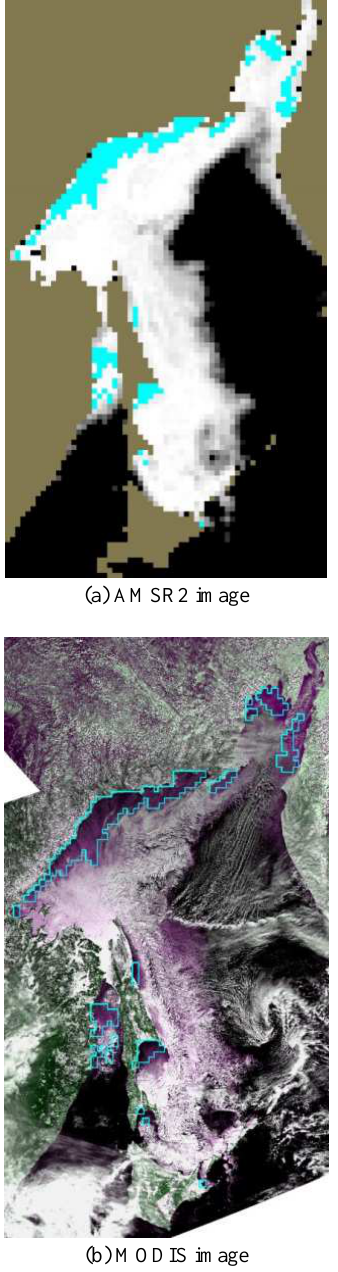
Figure 7. Thin ice area extraction result (Cyan: extracted area) (Sea of Okhotsk, February 27, 2013)